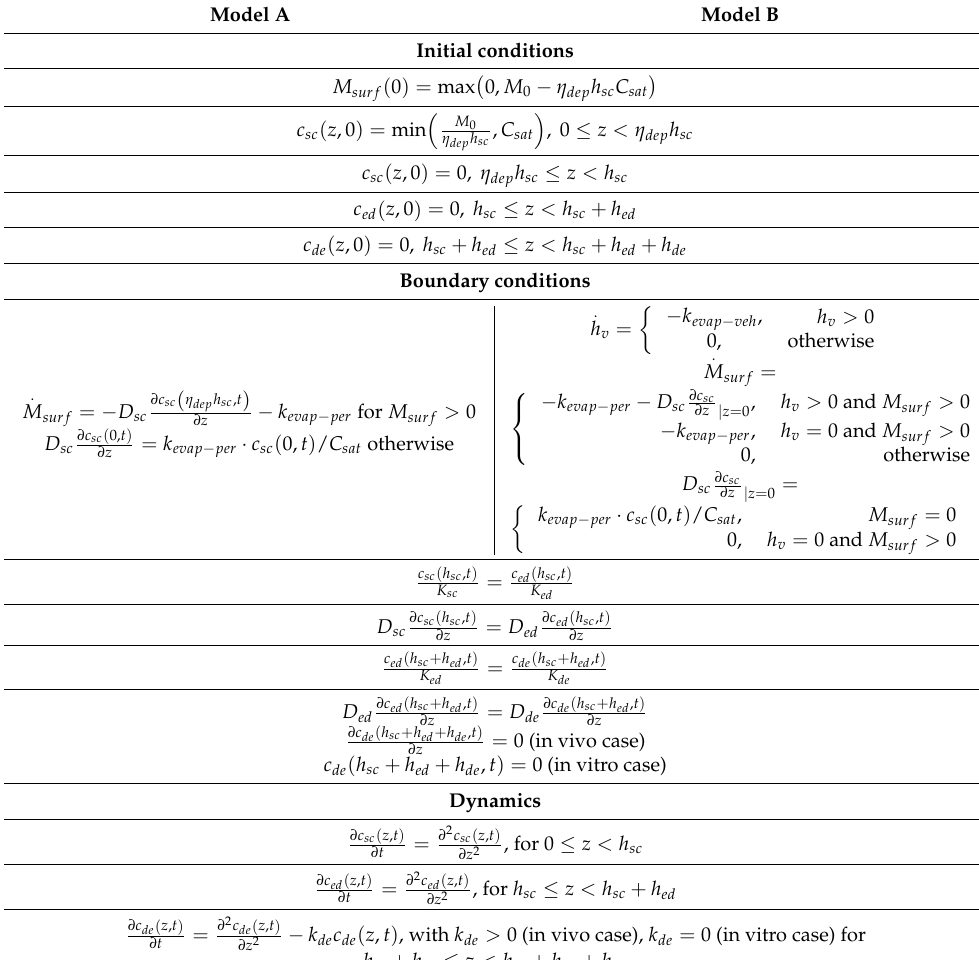
Table A2. Mathematical details of Models A and B.